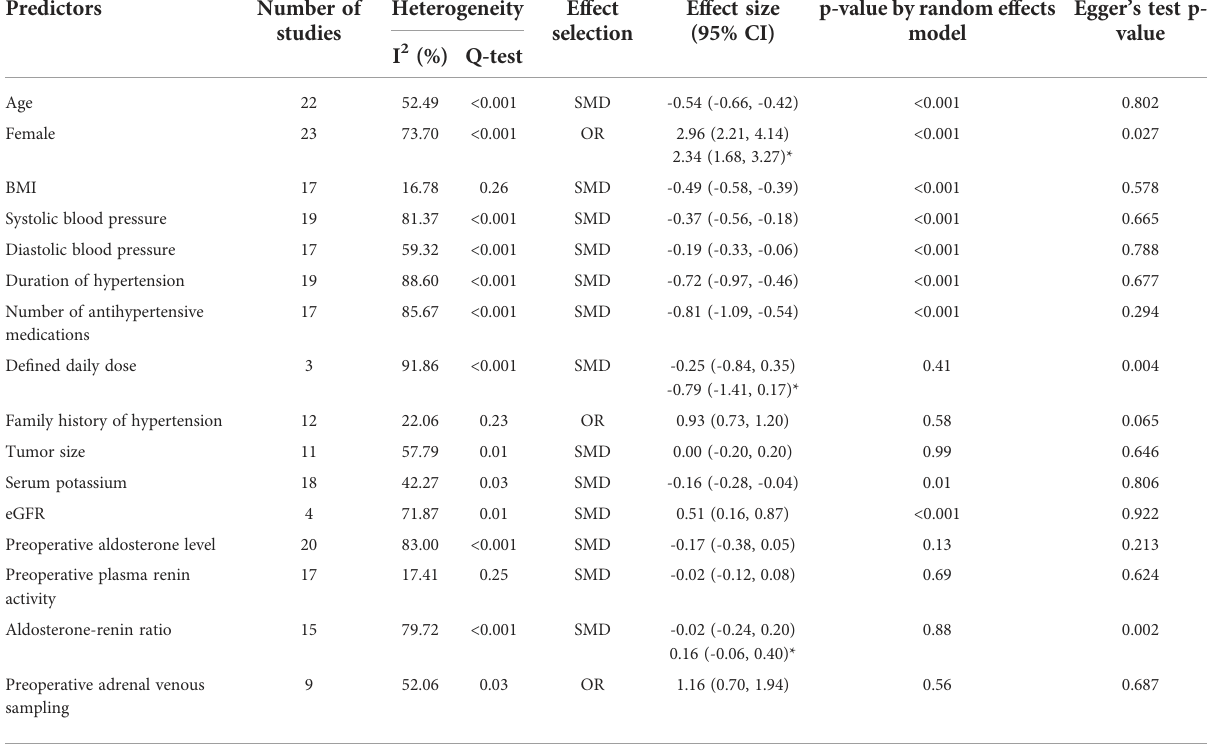
TABLE 3 Meta-analysis of predictive factors of clinical success after adrenalectomy in primary aldosteronism using crude data.